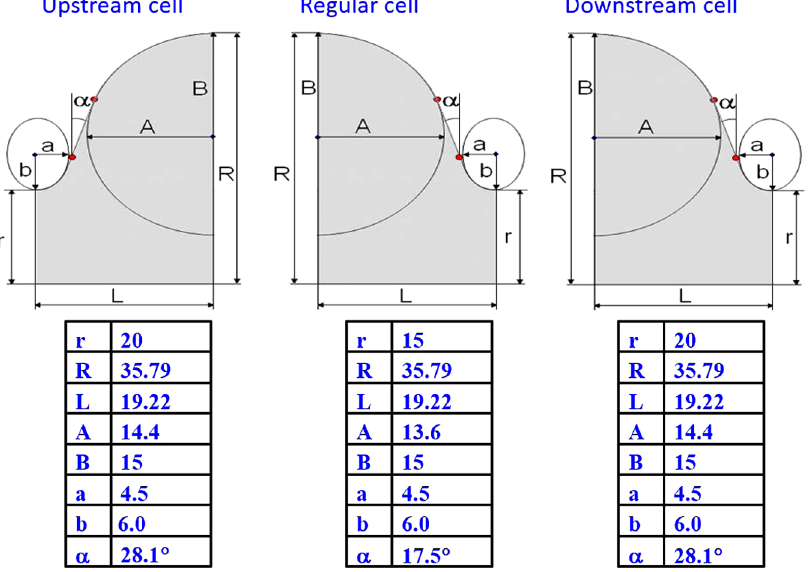
FIG. 7. Nominal geometry of the 3.9 GHz LCLS-II cavity (alpha is a reference parameter given in degrees; the other parameters are all in millimeters).